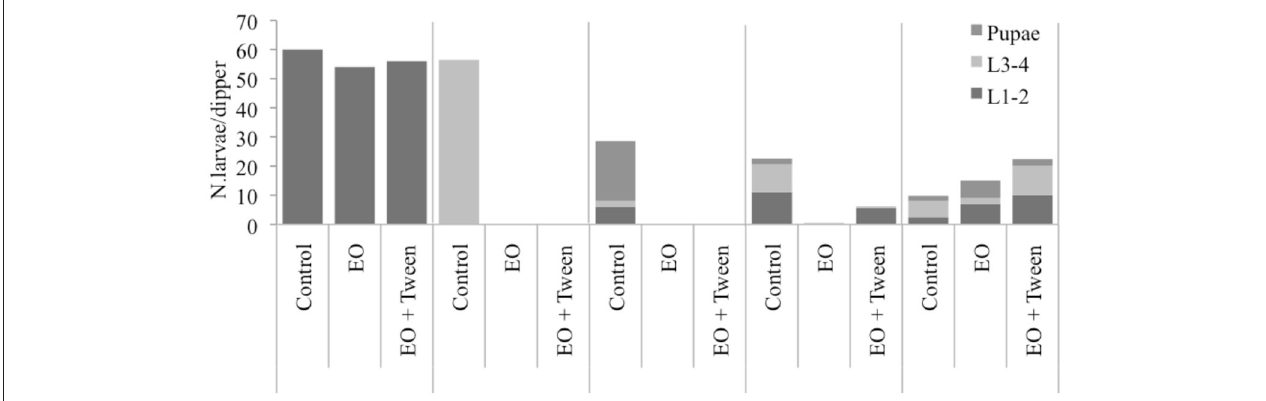
FIGURE 3 | Pre-imaginal mosquito population as sampled in experimental catch basins ( Culex pipiens + Aedes albopictus , 22 post treatment days) in Crevalcore, Italy.